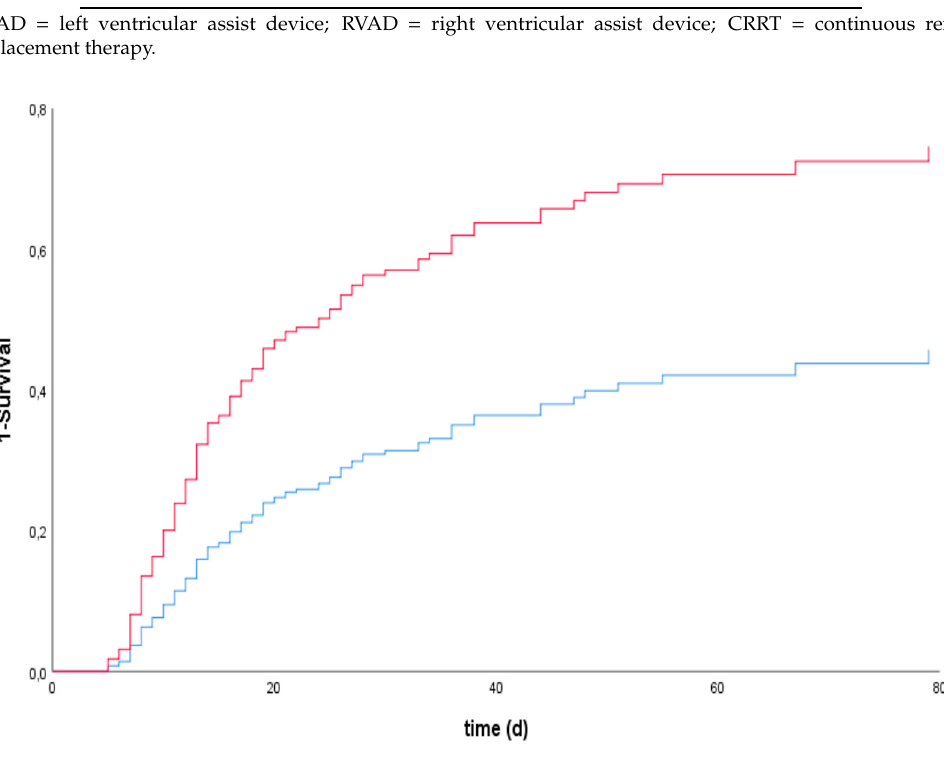
LVAD = left ventricular assist device; RVAD = right ventricular assist device; CRRT = continuous renal replacement therapy.